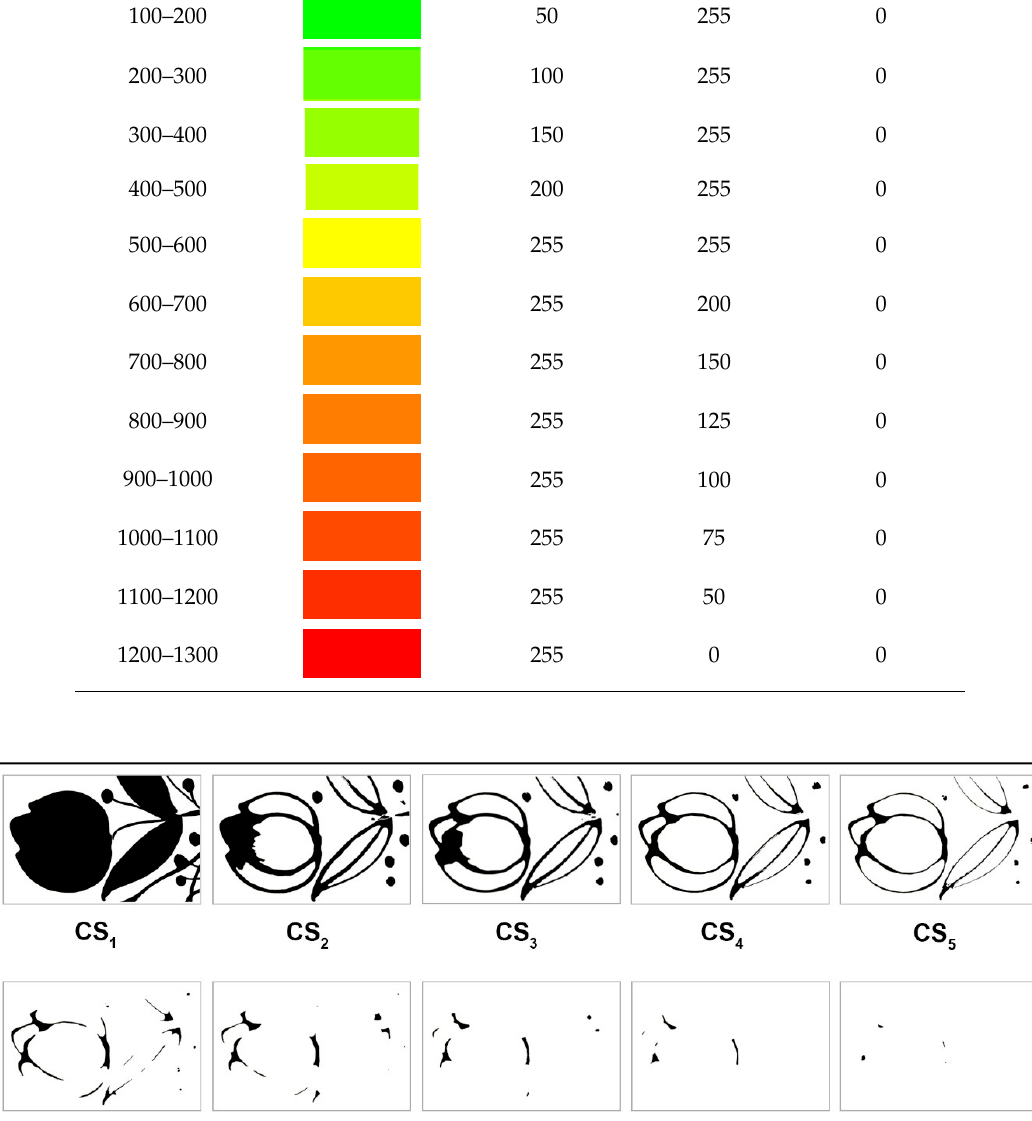
Figure 3. Cross-sections extraction of an oil painting model with blank mode.